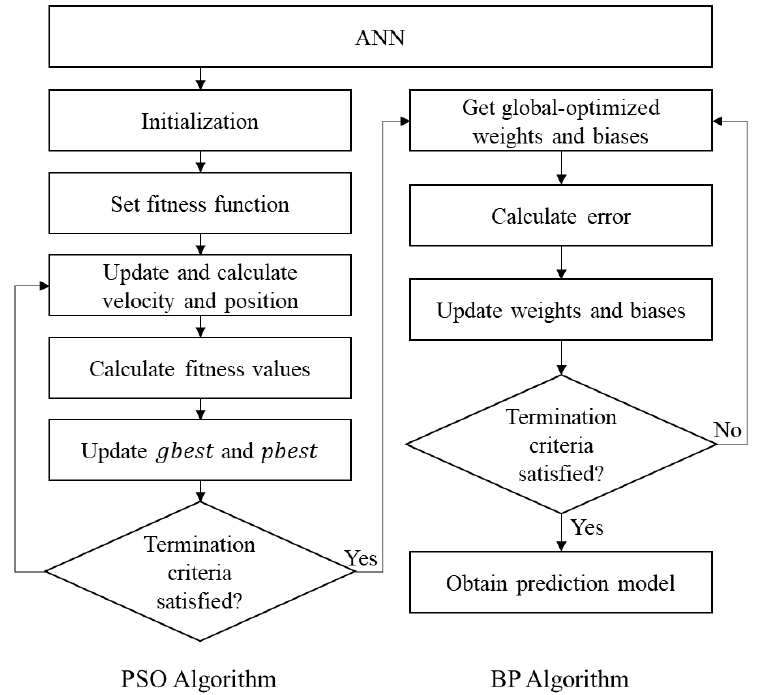
Figure 2. Flowchart for the hybrid particle swarm optimization-back-propagation (PSO-BP) algorithm .